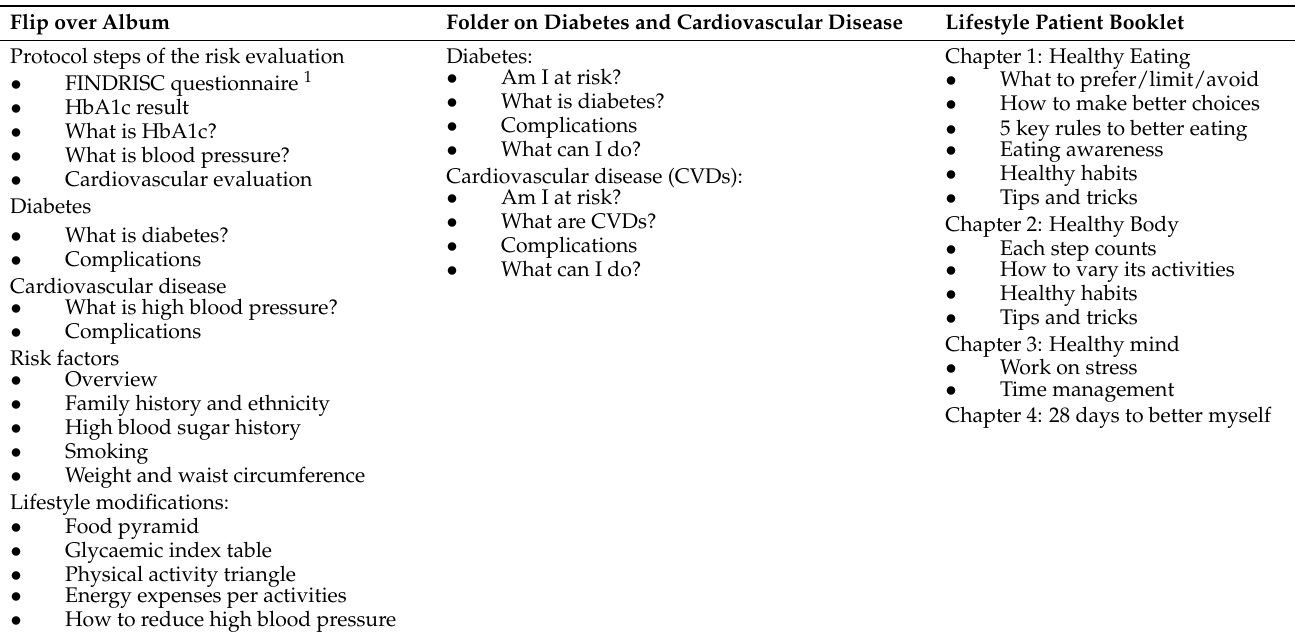
Table 1. Topics covered in the patient education